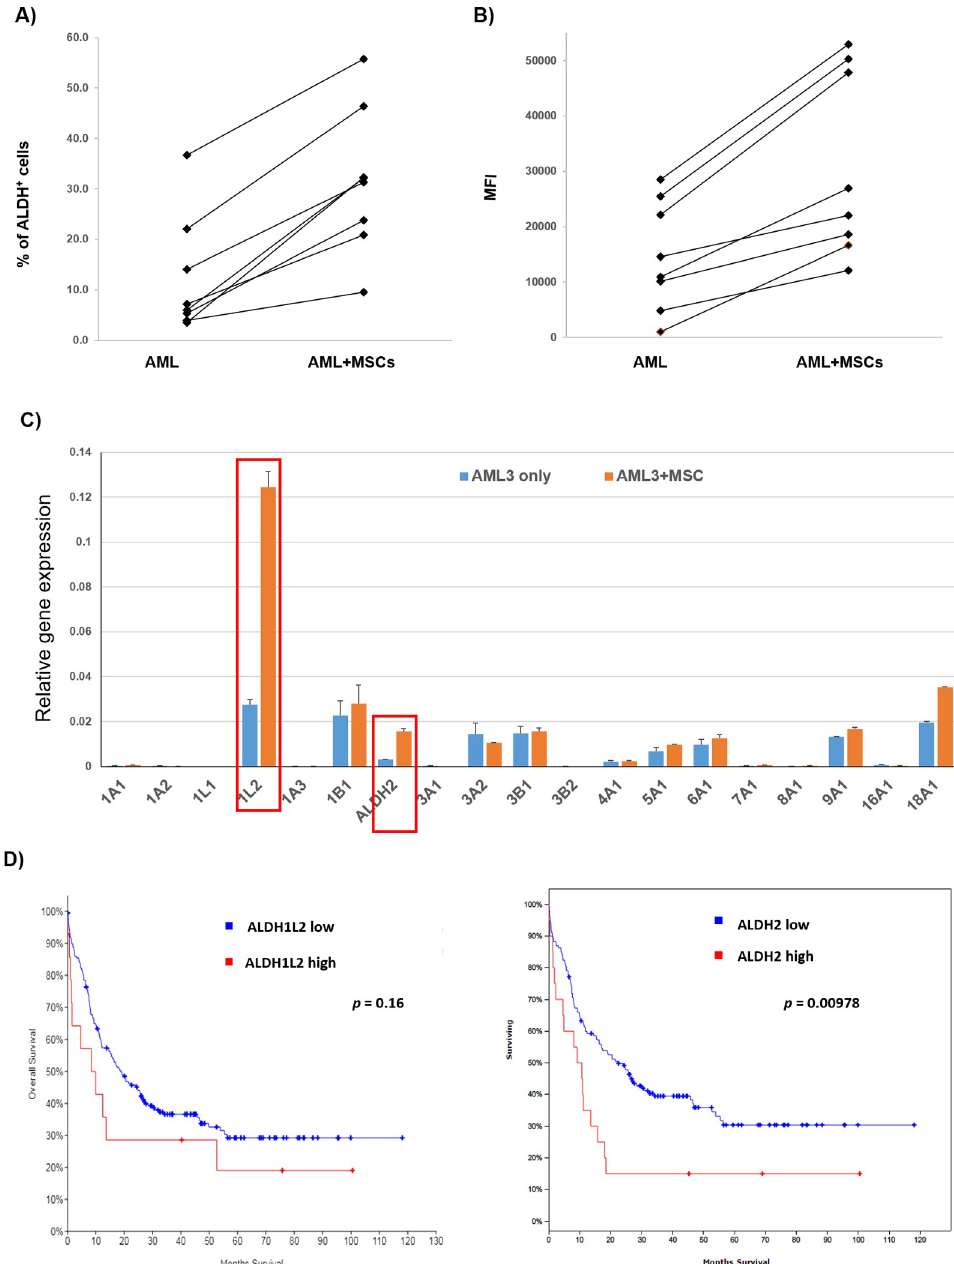
Fig 2. Differential expression of ALDH isoforms in AML cells co-cultured with BM-MSCs. (A, B) Patient-derived primary AML cells from bone marrow and peripheral blood samples were cultured with or without MSCs for 3 days and ALDH activity was measured using ALDEFLUOR 1 assay by flow cytometry. Data show a graphical representation of ALDH mean fluorescence intensity (MFI) and percentage of ALDH + AML patient samples when co-cultured with stromal cells. (C) Total RNA was extracted from 5 million AML cells. RT-PCR was performed to analyze gene expression of different ALDH isoforms using primers listed in S2 Table. All samples were run in triplicate. The relative fold increase of specific RNA was calculated by the comparative cycle of threshold detection method, and values were normalized to GAPDH. Fold changes in gene expression were calculated using the 2-ddC method after normalization to GAPDH. Data are plotted as mean values with error bars representing standard error . (D) AML expression data for ALDH isoforms and Kaplan-Meier survival analysis were obtained from the TCGA dataset. For A and B , the paired t test was used. For C , the Mann-Whitney U test/Student’s t test was used (N = 3). For D , the log-rank test was used to test the significance.